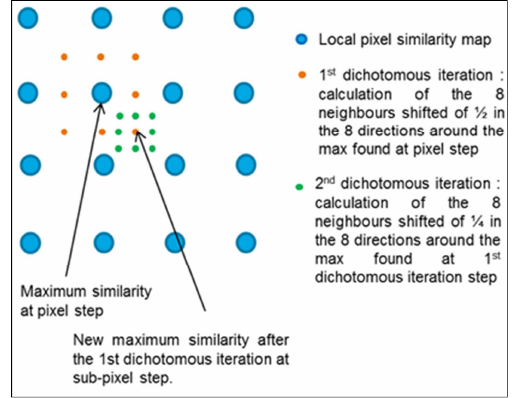
Figure 1 : QPEC / Medicis dichotomous approach on the local pixel similarity map. The pixel step, the 1st and 2nd dichotomous sub-pixel steps are here